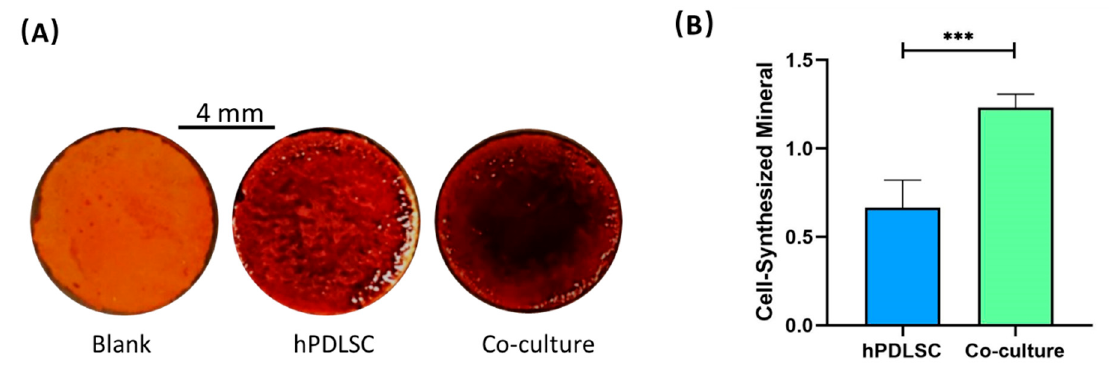
Figure 5. Bone mineral synthesis. ( A ) ARS staining images of CPC scaffolds at 14 days. ( B ) Quantitative assay of mineral synthesis at 14 days. Co-culture group synthesized more bone mineral compared to hPDLSC group. *** p <